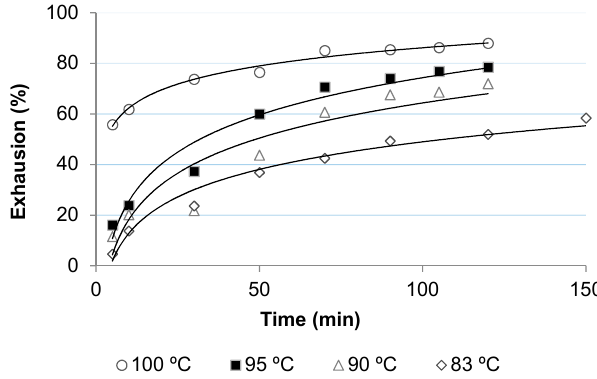
Figure 5. Dyeing kinetics for PES fabric dyed with Disperse Blue 79 and o -vanillin.